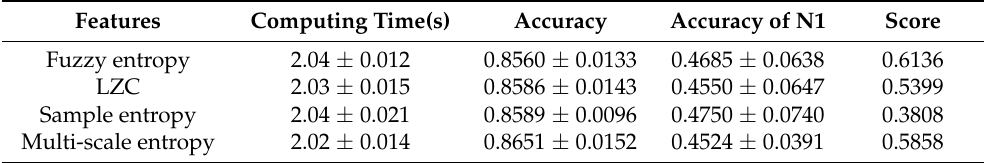
Table 5. The evaluation of nonlinear dynamics features.